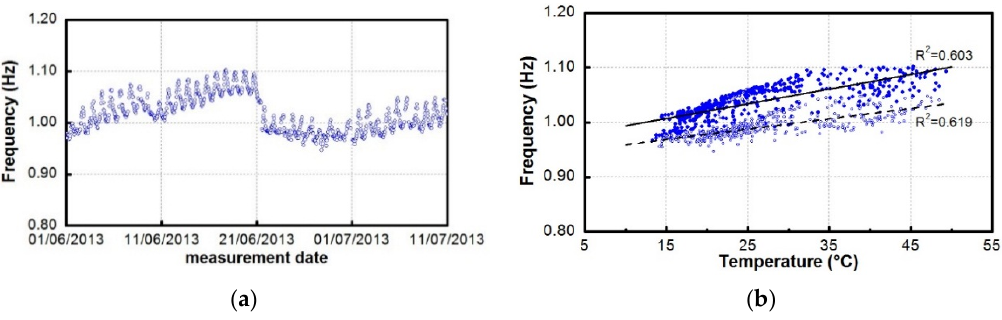
Figure 11. Mode B 1 : ( a ) variation of the natural frequency between 01/06/2013 and 10/07/2013; and ( b ) change in the frequency ‐ temperature correlation induced by the seismic event of 21/06/2013.